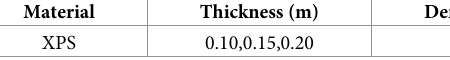
of the subbase layer), the temperature of the pavement varied from -3.1˚C to 9.0˚C. Therefore, the subbase layer of the graded crushed-rock could significantly reduce the temperature range of the time-dependent curve and was beneficial for maintaining the temperature stability of the subgrade. As shown in Fig 7, the temperature envelopes of the pavement and natural surface remained funnel-shaped over the year. The temperature ranges of the pavement and natural surface decreased as depth increased and tended to be constant. The upper temperature-depth curves of the pavement and natural surface that were shifted to the left indicated that low-tem- perature interlayers existed in the pavement structure and natural surface. Similarly, the upper temperature-depth curves that were shifted to the right indicated that high-temperature inter- layers existed in the pavement structure and natural surface. These temperature characteristics were similar to those observed in highway and railway engineering [28, 34]. As shown in Fig 7 (A), when the depth was 1.45 m (bottom of the subbase layer), the temperature of the pave- ment showed a steep decline. This phenomenon was similar to that shown in Fig 6(A) and also indicated that the subbase layer of the graded crushed-rock was suitable for reducing the tem- perature range of the depth-dependent curve to maintain temperature stability in the subgrade.